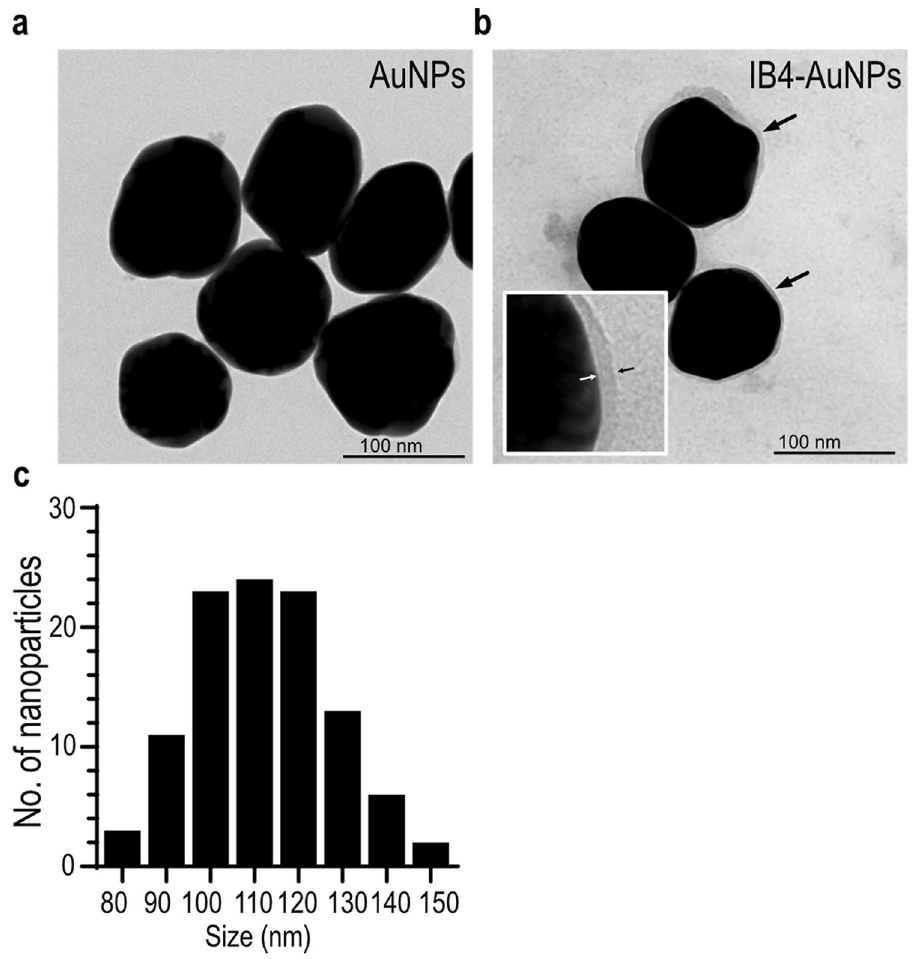
Figure 1. Surface functionalization of AuNP with IB4. Representative transmission electron microscopy (TEM) images of ‘as-synthesized’ citrate capped AuNP (a) and IB4-AuNP (b) . Arrows indicate a corona on AuNP surface (inset), suggestive of IB4 adsorption. Histogram (c) depicting AuNP diameter quantified from 15 non- overlapping TEM micrographs (n = 105